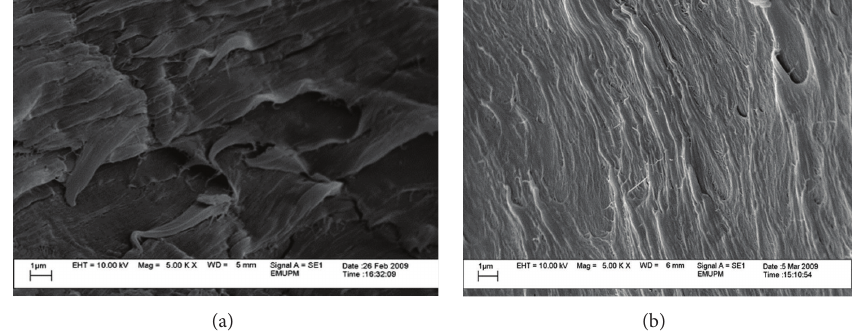
Figure 8: SEM micrograph of the fractured surface of PP/1% nano 𝛼 -Al 2 O 3 composites (a) in the presence of dispersant and (b) in the absence of dispersant.